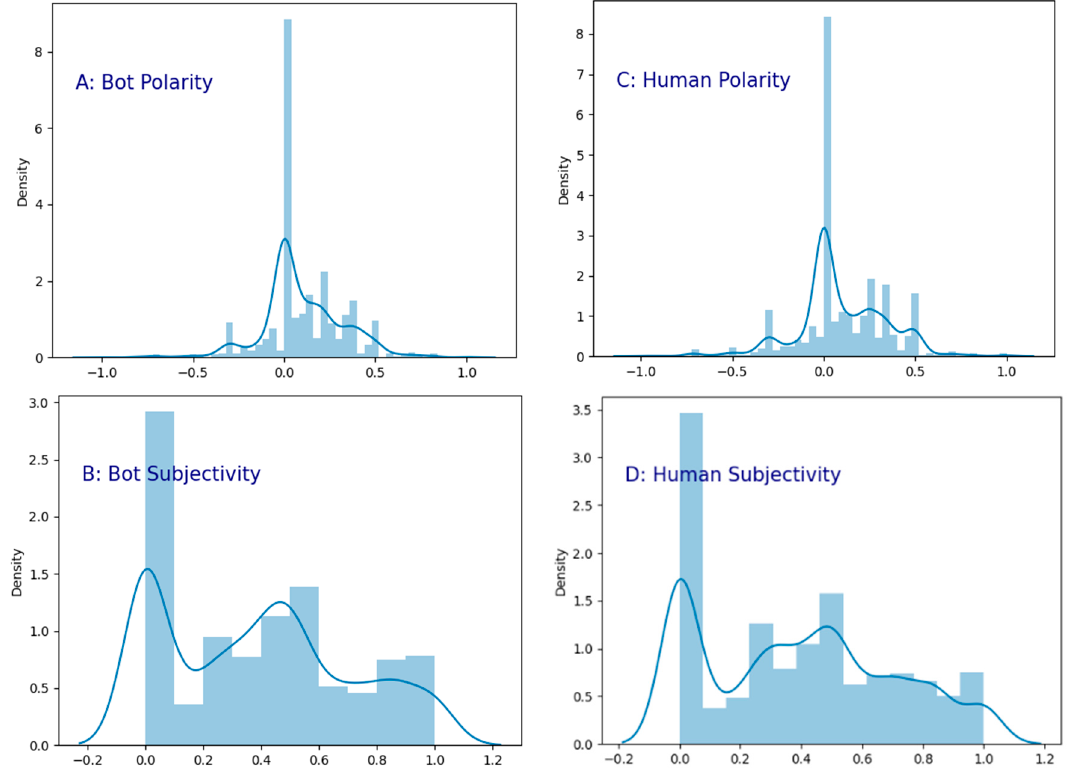
Figure 8. Sentiment analysis of content posted by social bots and humans on Twitter.